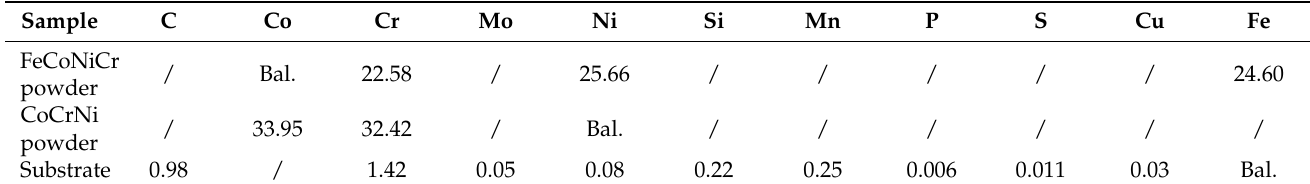
Table 1. Chemical compositions of the powders and substrate (At%).